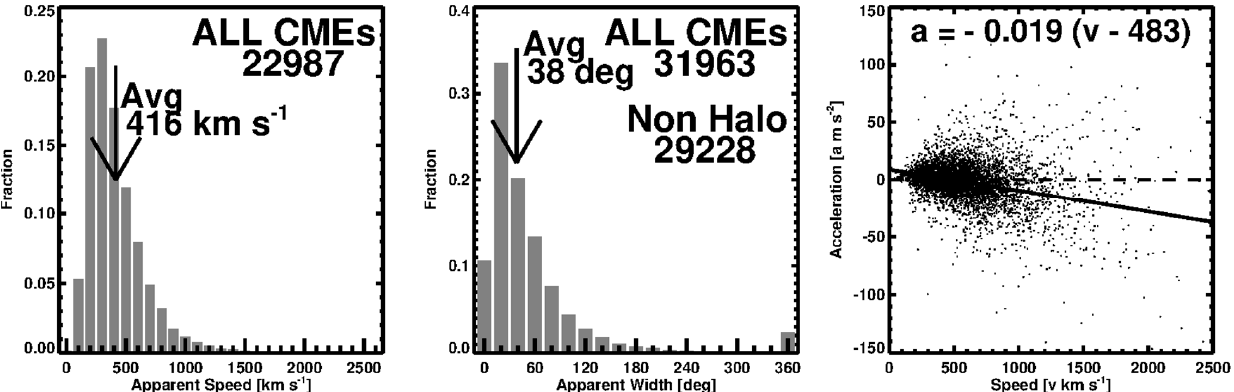
Figure 2. Speed ( left ) and width ( middle ) distributions of CMEs detected by SOHO/LASCO from 1996 to November 2021. ( right ) A scatter plot between CME speed and the acceleration within the LASCO FOV. The number of CMEs is different between the speed and width panels because speed measurements are not possible in many events.